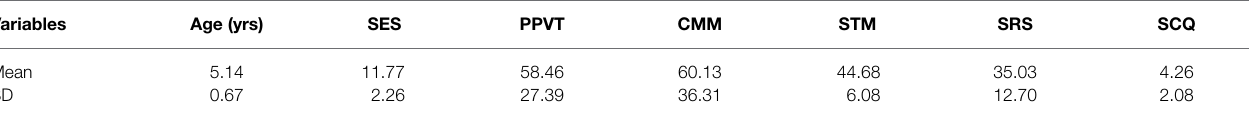
TABLE 1 | Participant demographics and